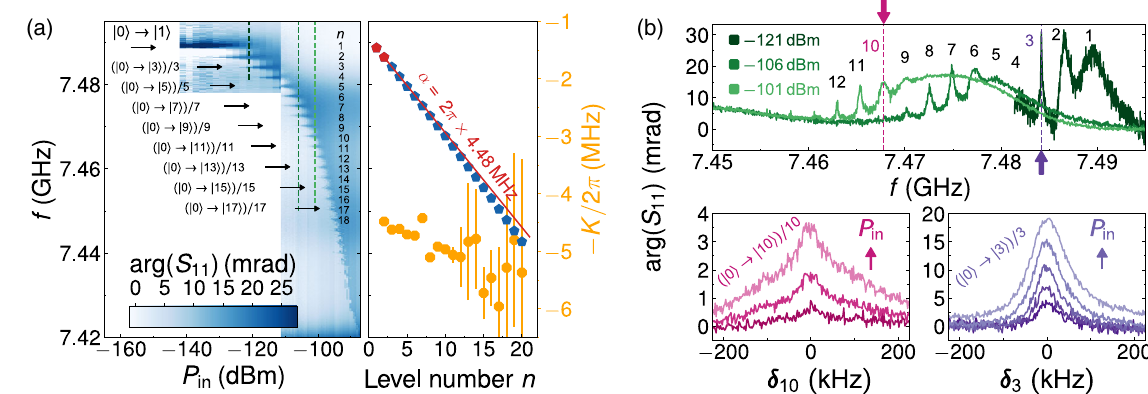
FIG. 3. Energy spectrum. (a) Phase of the measured reflection coefficient arg ð S 11 Þ as a function of probe frequency f and incident on- chip power P (left-hand panel). With increasing probe power we observe multiphoton transitions at frequencies f , labeled n in ðj 0 i → j n iÞ =n , where n denotes the level number, which are almost equidistant in frequency, as plotted in the right-hand panel. For clarity we only highlight with arrows the odd n transitions; all indices n are listed on the right-hand side of the 2D plot. From the first two points in the right-hand panel (highlighted in red) we extract the qubit anharmonicity α ¼ K ð 1 Þ ¼ 2 π × 4 . 48 MHz, much larger than the total linewidth κ þ γ ¼ 2 π × 50 kHz (see Fig. 2). To highlight the change in K ð n Þ with increasing level number n (see main text), the red line shows a linear extrapolation from the first two points. The extracted values K ð n Þ are plotted in orange using the right-hand axis. − 121 , − 106 , and − 101 dBm), as indicated (b) Three individual measurements (top panel) performed at different probe powers ( P in ¼ by the vertical dashed lines in the 2D plot in (a). Several multiphoton transitions are visible. With increasing power the linewidth of these − 127 to − 123 dBm) and n ¼ 10 (left-hand transitions broadens, as shown in the bottom panels for n ¼ 3 (right-hand panel, P in ¼ − 105 . 75 to − 104 . 75 dBm). Here, δ f − f panel, P , with f 3 ¼ 7 . 4842 GHz and f 10 ¼ 7 . 4678 GHz, as indicated by the arrows n ¼ n in ¼ in the top panel. In Appendix D we show that these experimental results can be quantitatively reproduced by a master-equation simulation.